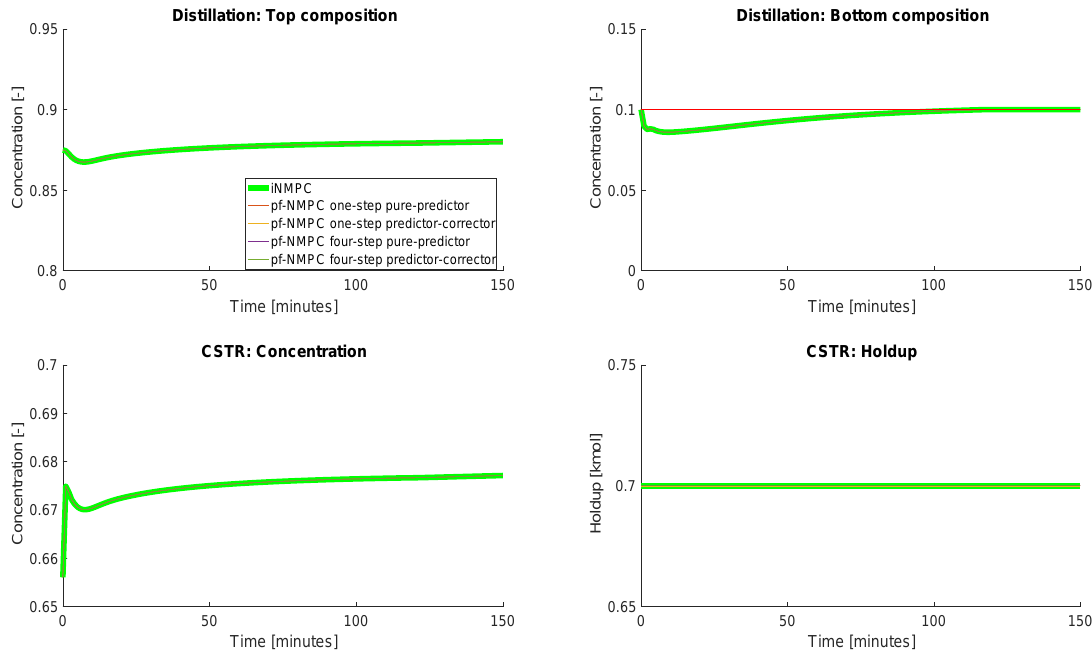
Figure 4. Recycle composition, bottom composition, reactor concentration, and reactor holdup.